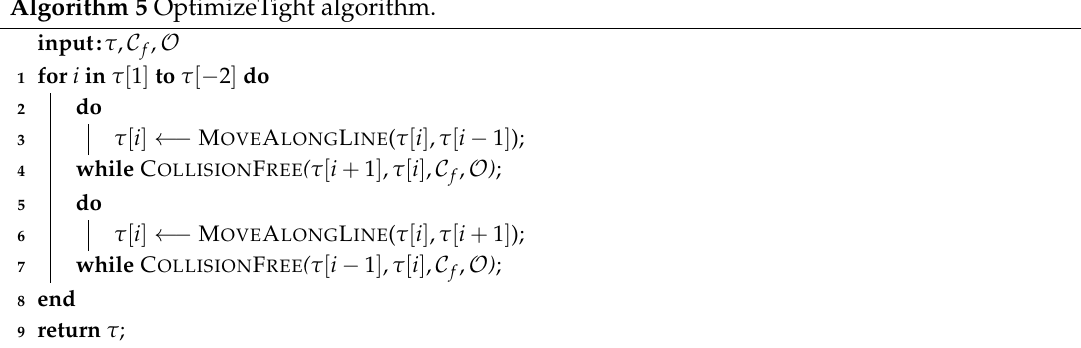
Algorithm 5 OptimizeTight